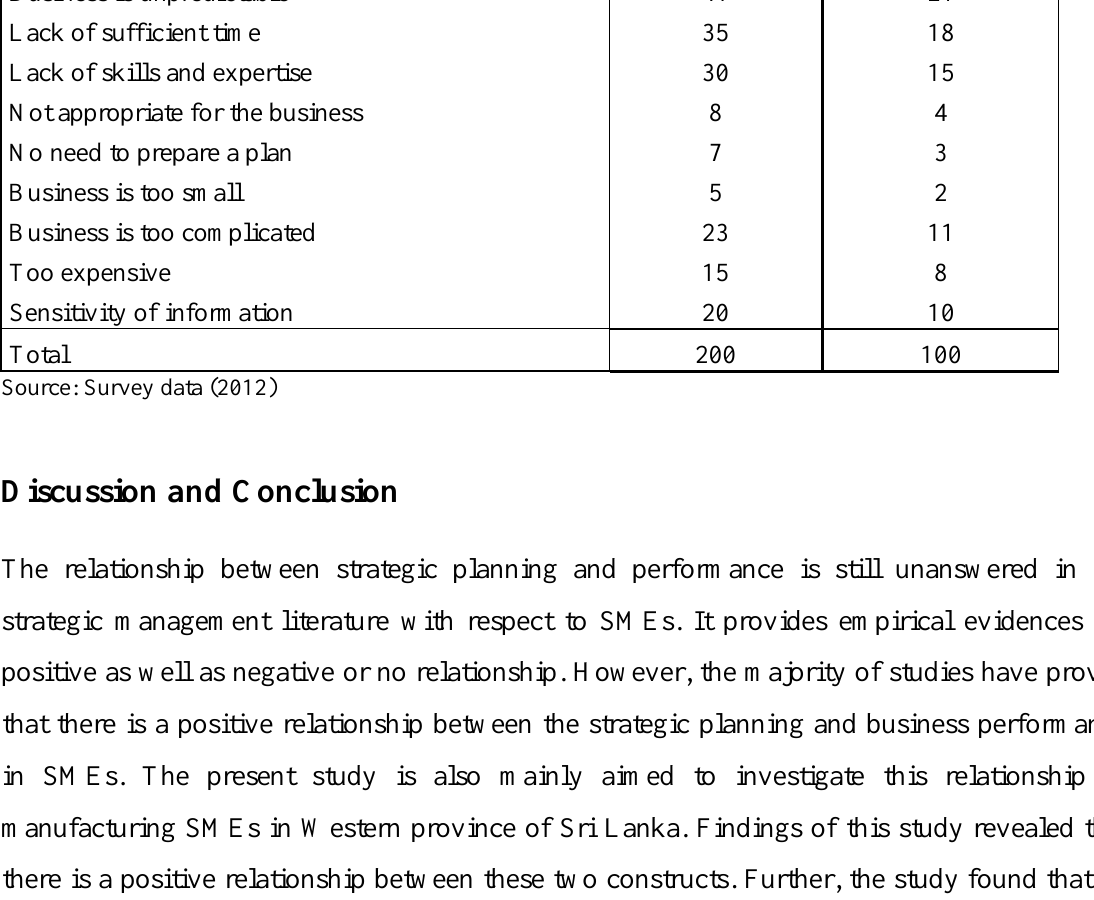
Table 9: Most Important Barrier in Strategic Planning Barrier No. of SMEs Percentage Having a mental plan 16